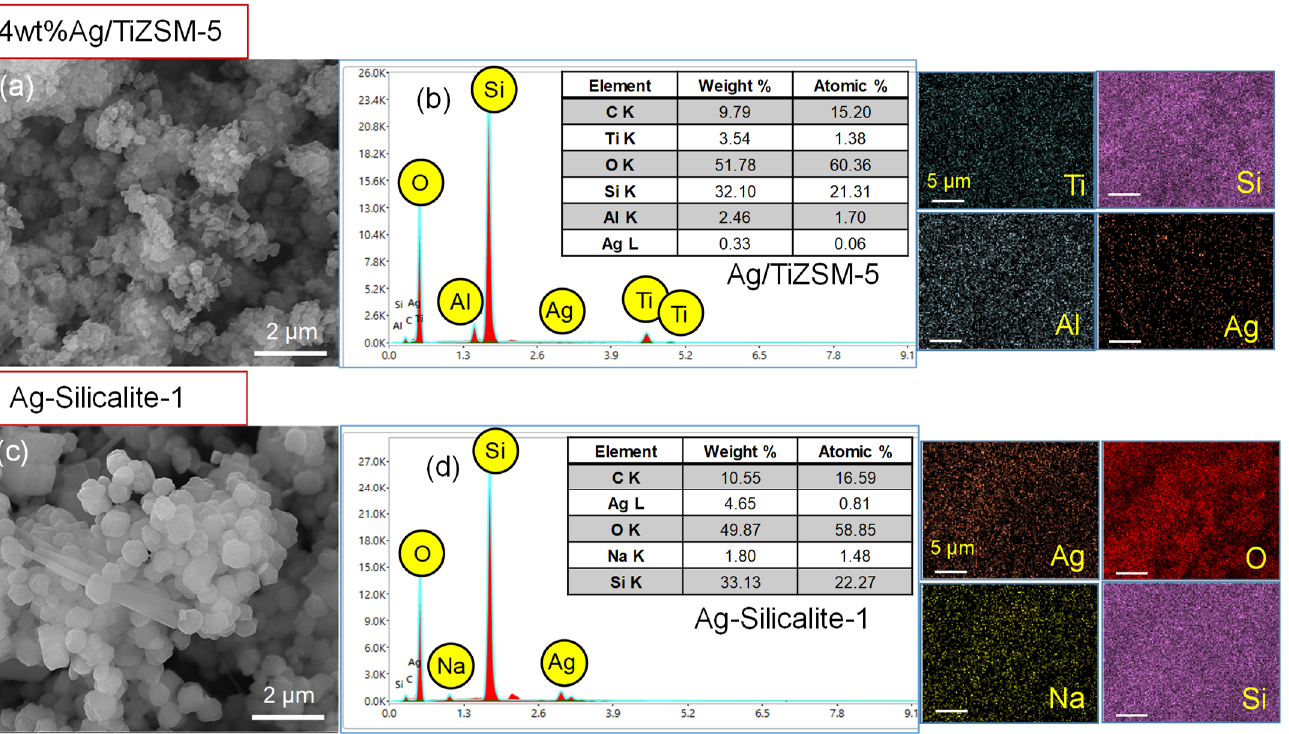
Figure 7. SEM, EDX spectra and EDX mapping images of Ag impregnated TiZSM-5 ( a , b ) 4 wt%Ag/TiZSM-5 and ( c , d ) Ag-silicalite-1. The scale bars are 5 µm in EDX mapping images.